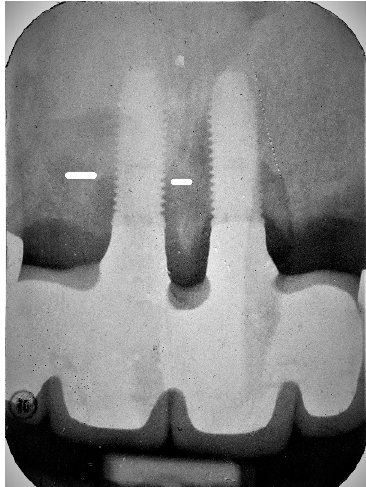
Figure 2. Baseline periapical radiograph at disease diagnosis of implant #11 with bone level located on the implant’s 5th thread.